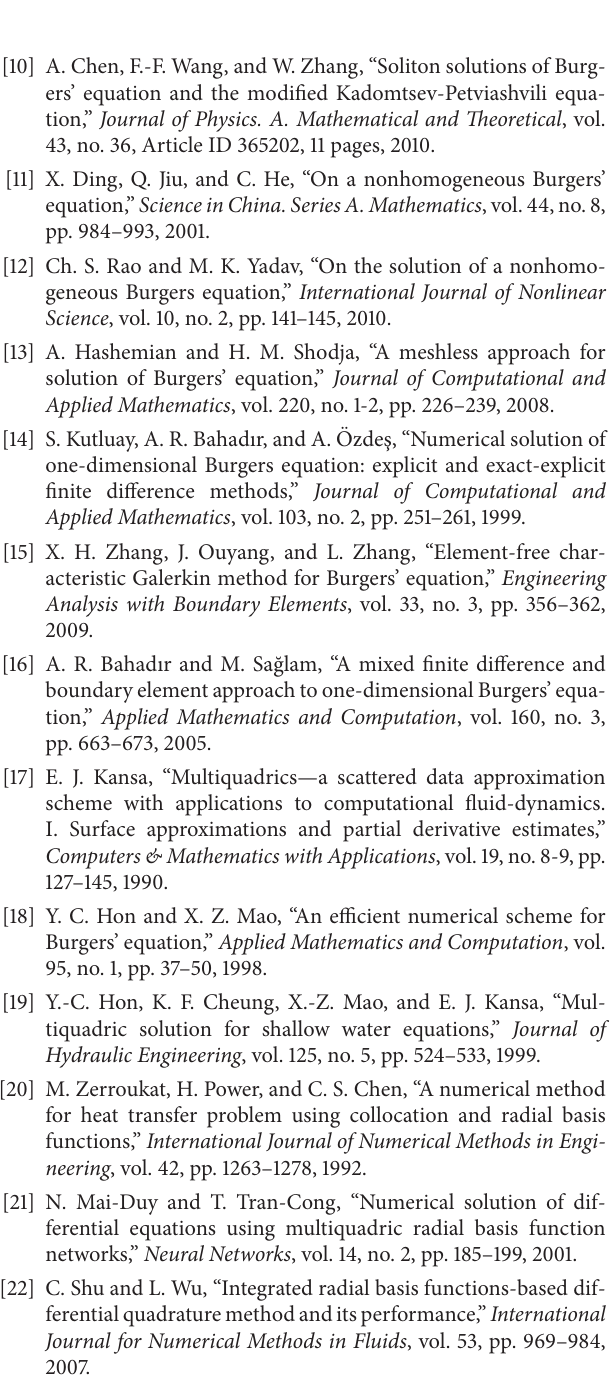
Table 9: Comparison of numerical results with the exact solutions for 𝜐 = 0.1 with 𝑞 = 100 and Δ𝑡 = 0.001 at 𝑡 = 3 of Experiment 5. 𝑥 Exact IMQQI DMQQI Error Error 𝑁 = 20 𝑁 = 30 𝑁 = 30 𝑁 = 60 IMQQI DMQQI 0.5 0.4824 0.4853 0.4851 0.4822 0.4851 2.679𝐸 − 03 1.0 0.9331